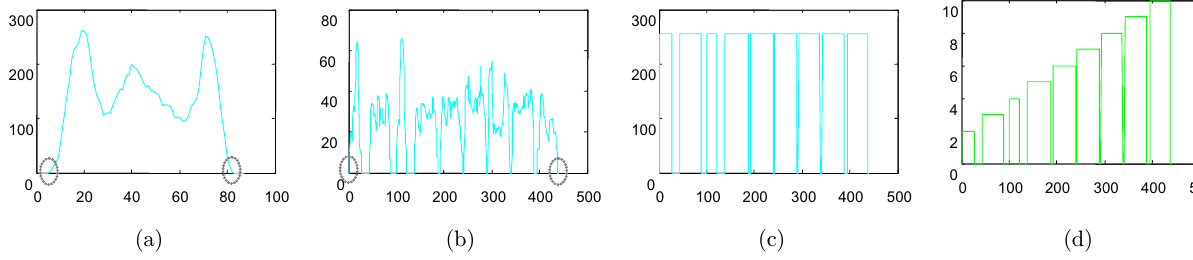
Fig. 9. Projection mapping curves and processing. (a) Horizontal projection mapping, (b) vertical projection mapping, (c) binary vertical projection mapping and (d) region labeling.